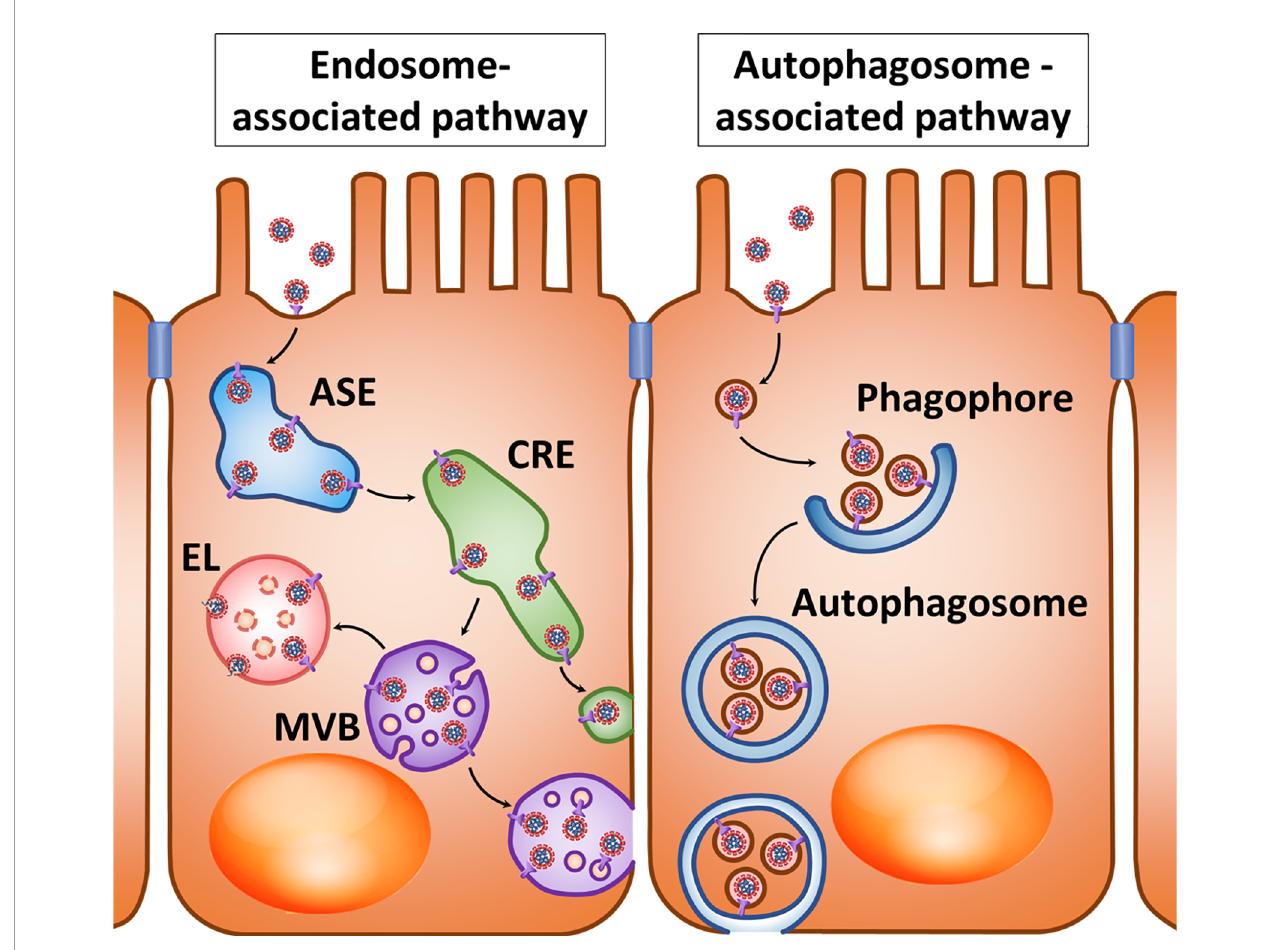
FIGURE 1 | Hypothetical pathways for SARS-CoV-2 transcytosis after interaction with ACE2. Left : After interacting with ACE2, virions enter the apical sorting endosome (ASE) and next common recycling endosome (CRE), from where they can be directed into vesicles either to the basolateral membrane or multivesicular bodies (MVBs). When an MVB fuses with lysosomes, endolysosome (EL) is formed; however, disruption of this process may promote the fusion of virion-containing MVB with the cytoplasmic membrane. Right : the presence of an LC3-interacting region motif in the cytoplasmic tail of ACE2 may suggest interaction of vesicles with virions with the phagophore and their accumulation in the autophagosome. Factors that prevent the fusion of autophagosomes with lysosomes create conditions for their fusion with the cytoplasmic